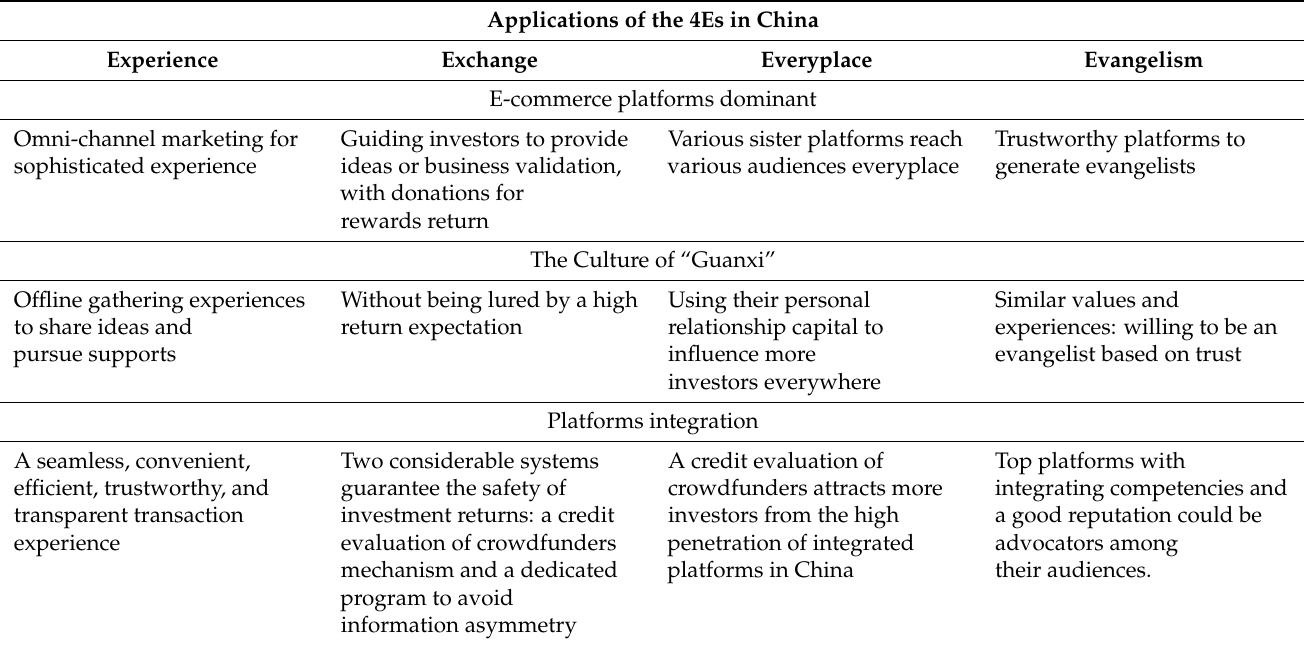
Table 3. Application of the 4Es marketing mix in the context of crowdfunding in